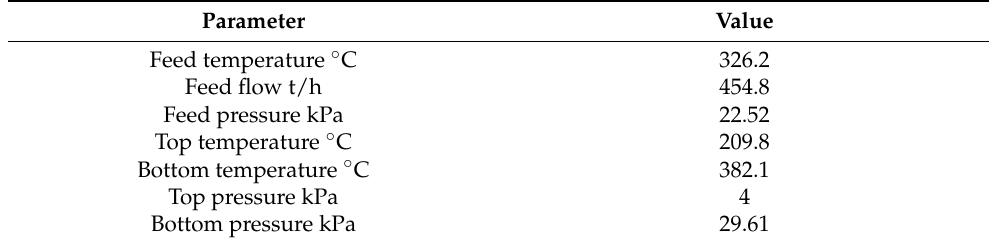
Table 6. Basic parameters of vacuum